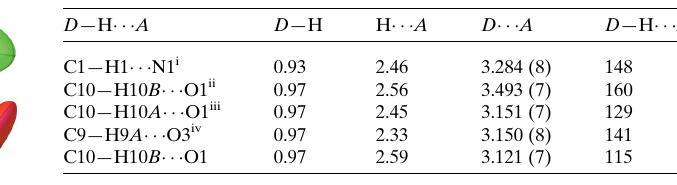
Table 1 Hydrogen-bond geometry (A˚ , (cid:3) ).